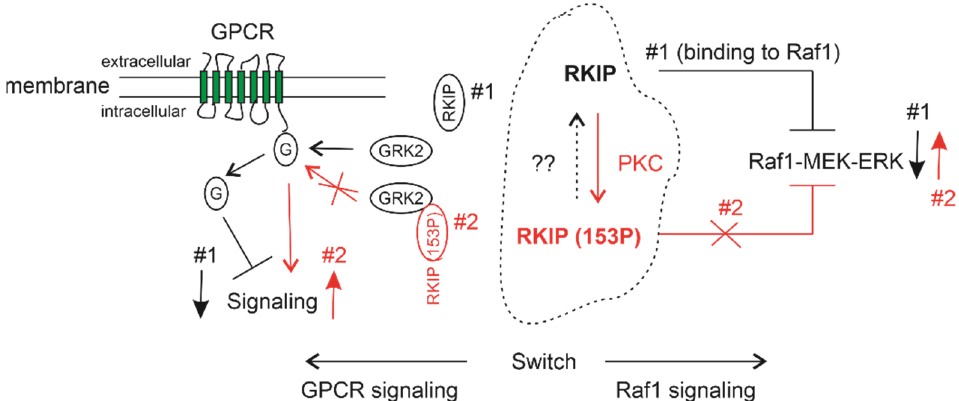
Figure 2. RKIP is a switch in regulating the Raf1-MEK-ERK and GPCR signaling. The dotted regions shows that RKIP can be phosphorylated at serine 153 (S153) by PKC and reversed to non-phosphorylated status by unknown factors marked with “??”. At non-phosphorylated status (#1), RKIP binds Raf1 and inhibits Raf1-MEK-ERK signaling. Non-phosphorylated RKIP does not associated with GRK2, which enables GRK2 to phosphorylate active GPCR, leading to G proteins to dissociate from GPCR and thereby inhibiting GPCR signaling. RKIP(S153P) is unable to bind or dissociate from Raf1 (#2), resulting in activation of the Raf1-MEK-ERK signaling. RKIP(S153P) binds to GRK2 and prevents GRK2 from uncoupling GPCR from G protein, in turn stabilizes the GPCR-G protein complex and promotes GPCR signaling.